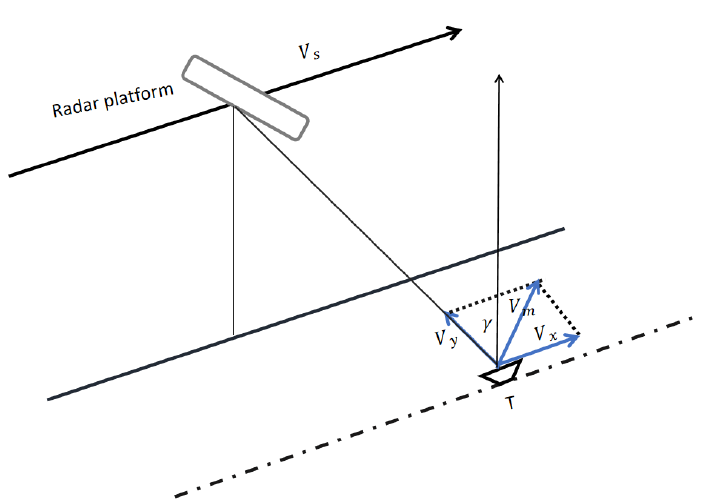
Figure 7. Schematic diagram of the geometric relationship between the satellite and the